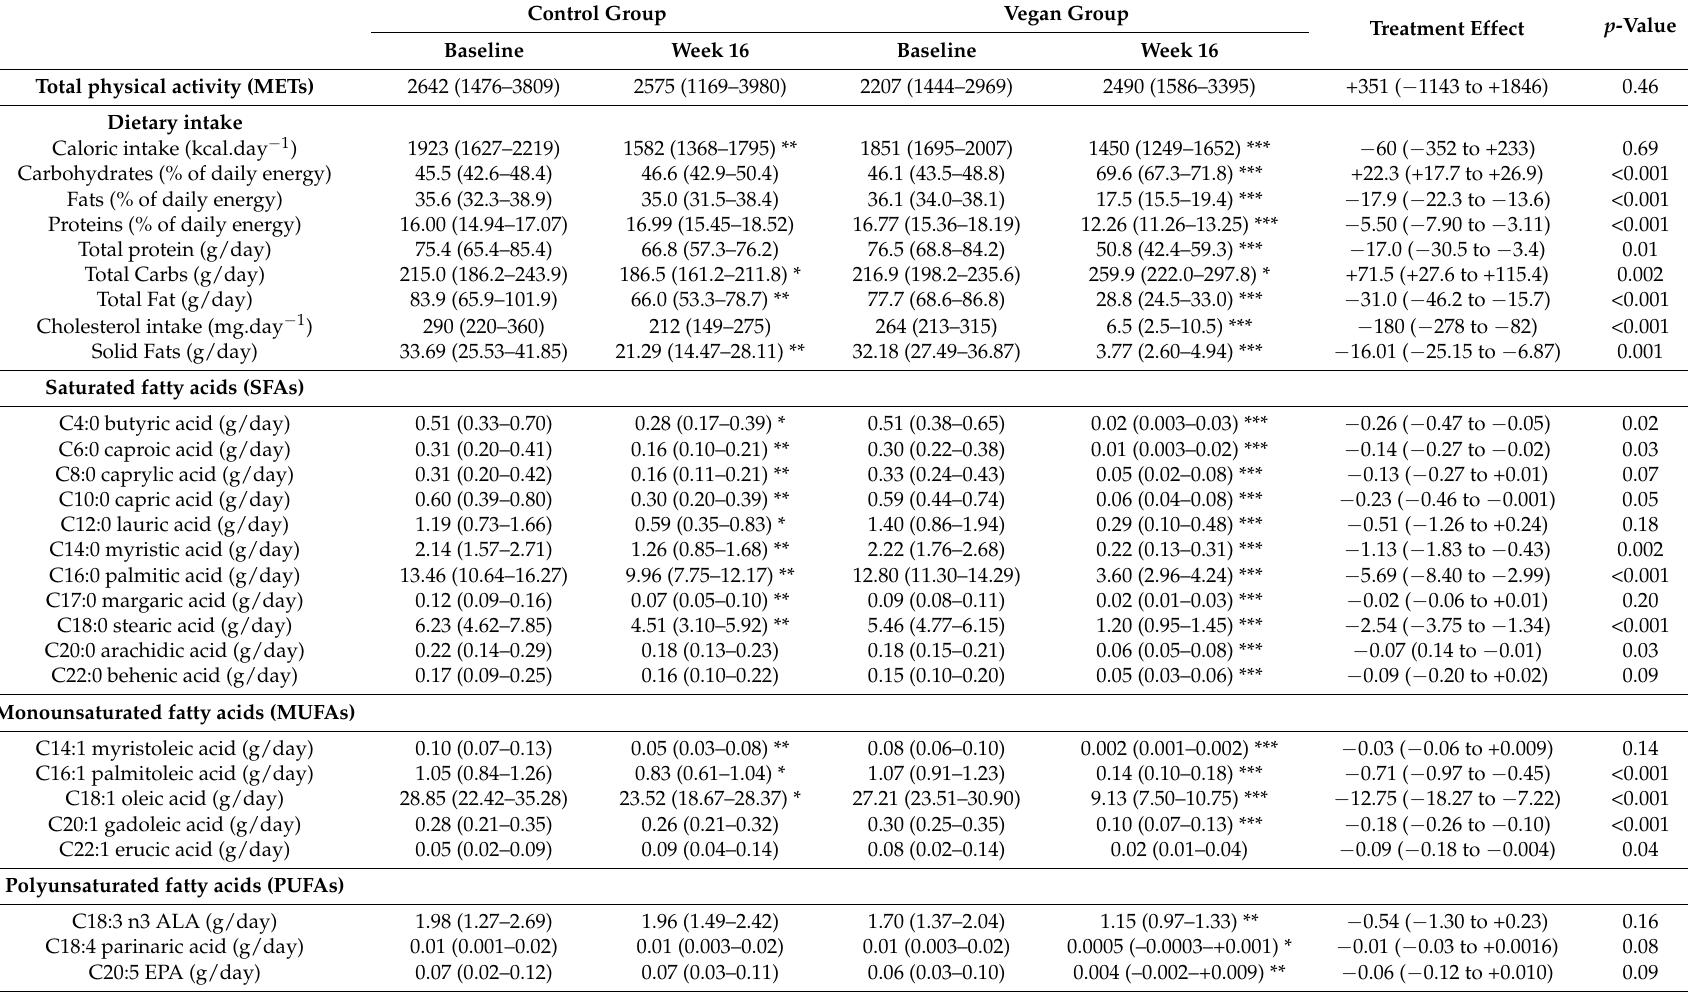
Table 2. Changes in physical activity, dietary intake, and laboratory and anthropometric variables during the study. Control Group Vegan Group